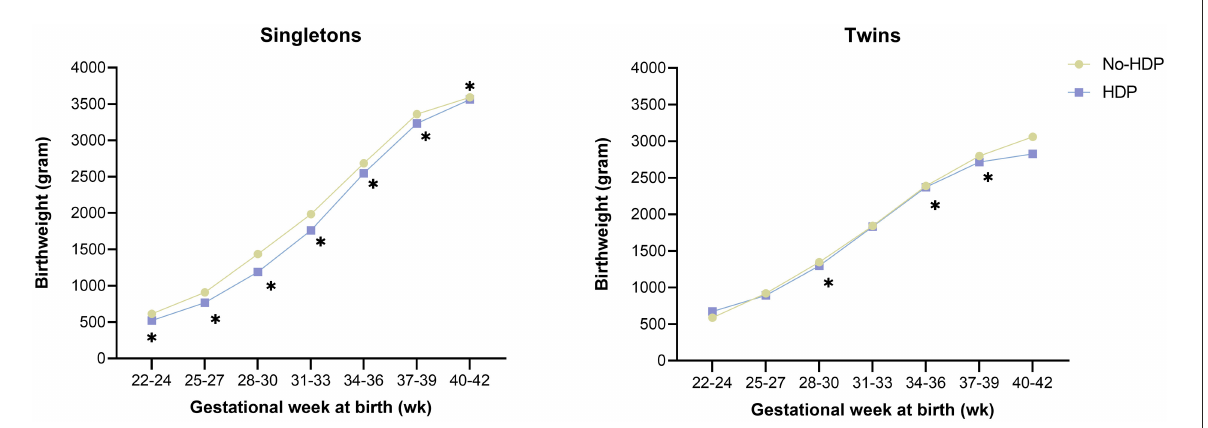
FIGURE2 Relationship between HDP and gestational age-specific birthweight by plurality among ART mothers. HDP, Hypertensive disorders in pregnancy. Asterisk indicates a value of P <